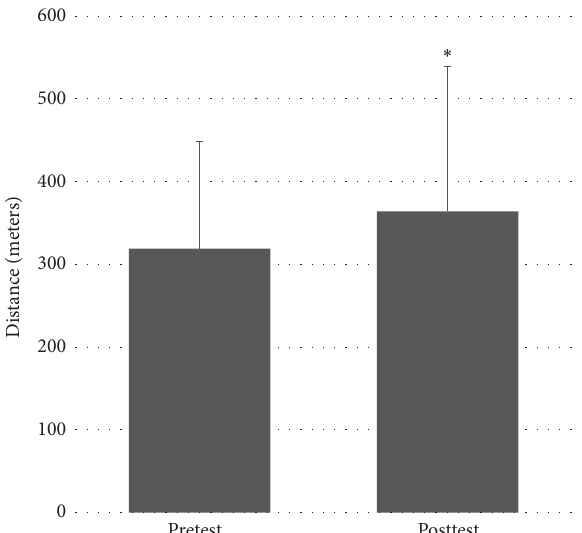
Figure 3: Pretest and posttest values for 6-Minute Walk Test distance. ∗ denotes statistically significant difference at 𝑃 < 0.05 .